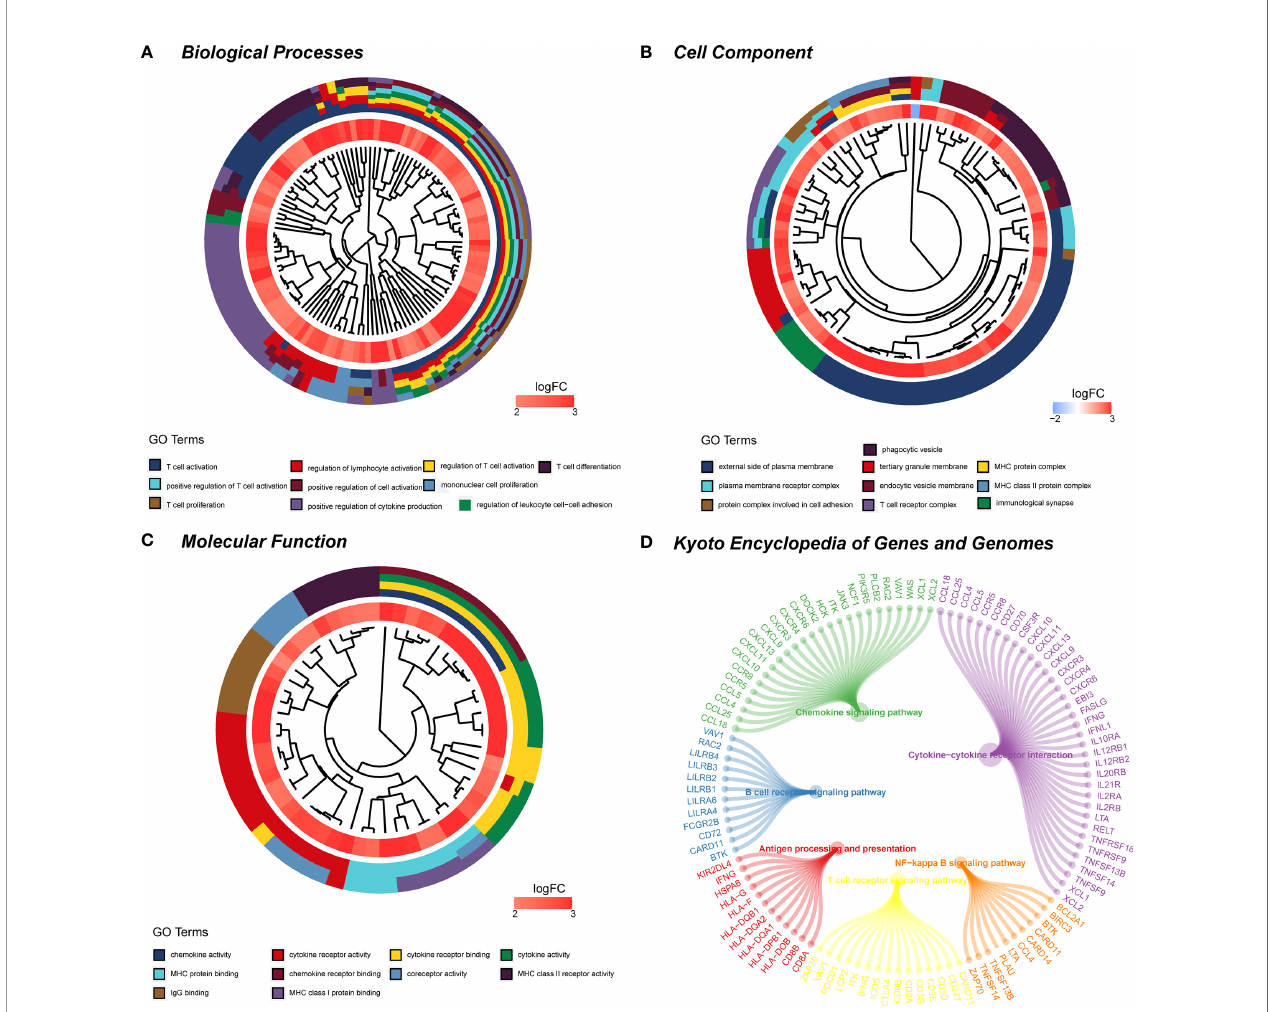
FIGURE 12 | Functional enrichment analysis and signaling pathway analyses of genes associated with radiomic signature. (A) Biological process. (B) Cellular components. (C) Molecular functions. (D) KEGG pathway. KEGG, Kyoto Encyclopedia of Genes and Genomes